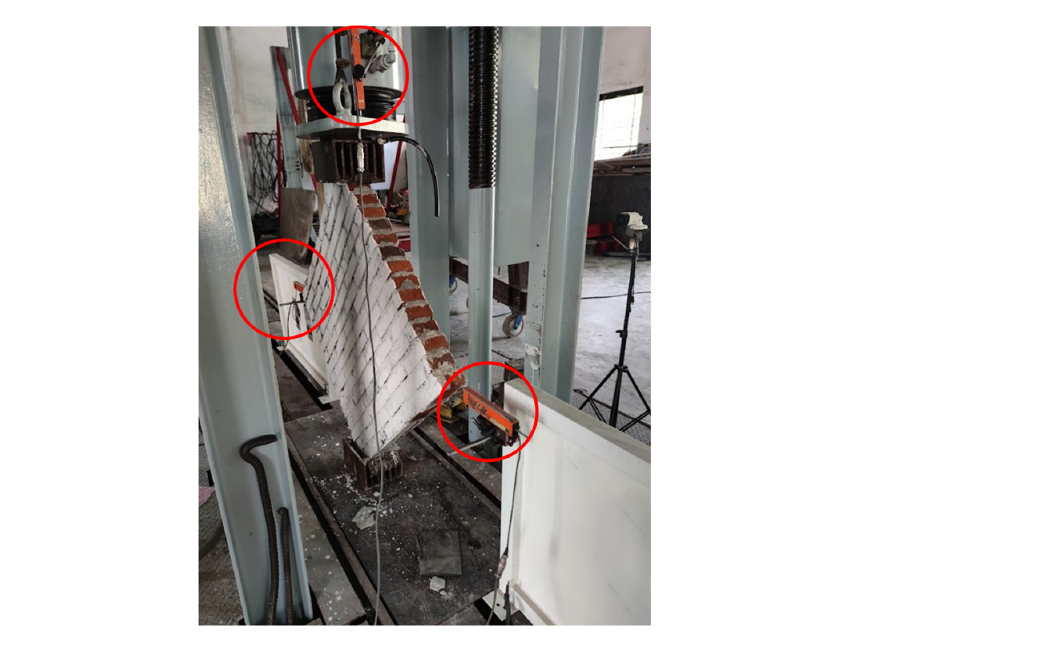
Figure 10. Masonry panel under compression test and LVDTs for displacement measurements.